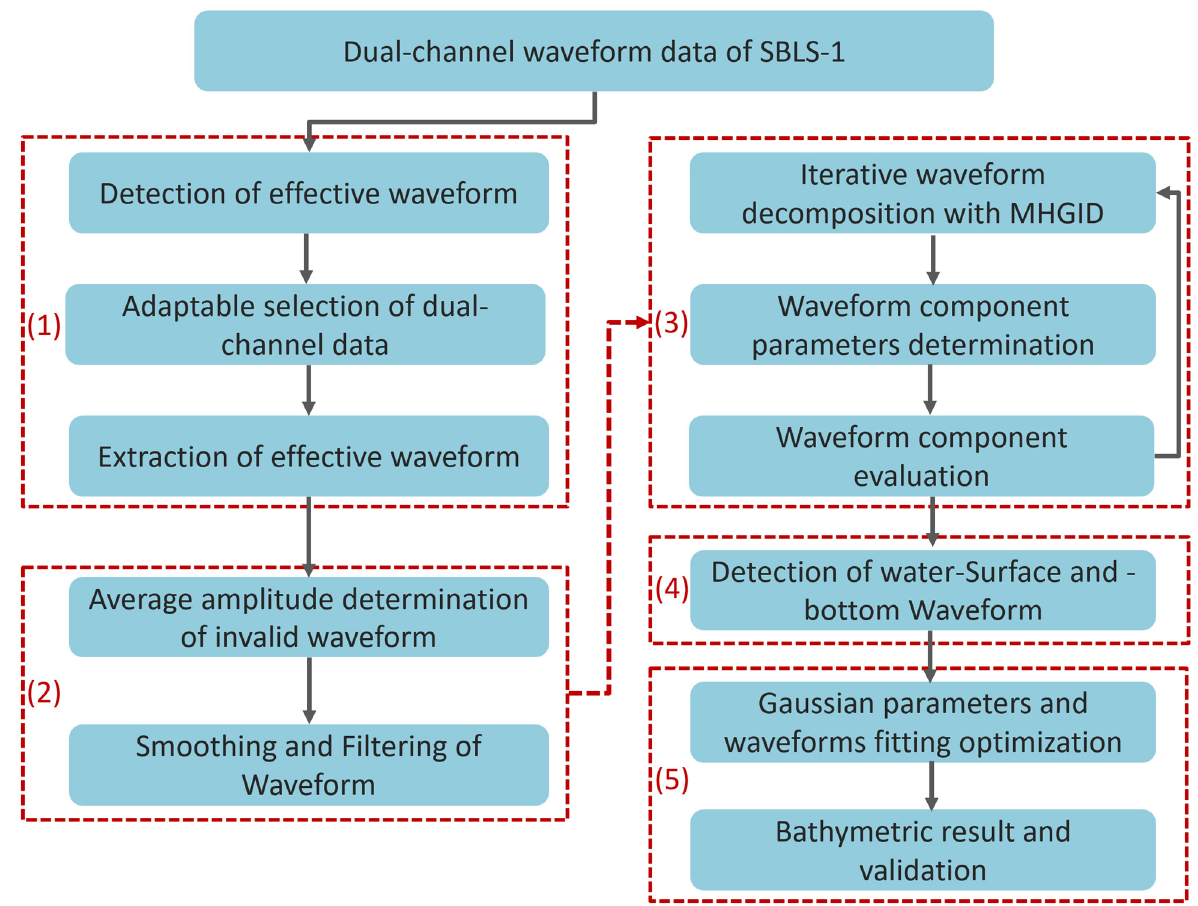
Figure 1. Flow chart of the bathymetric method for